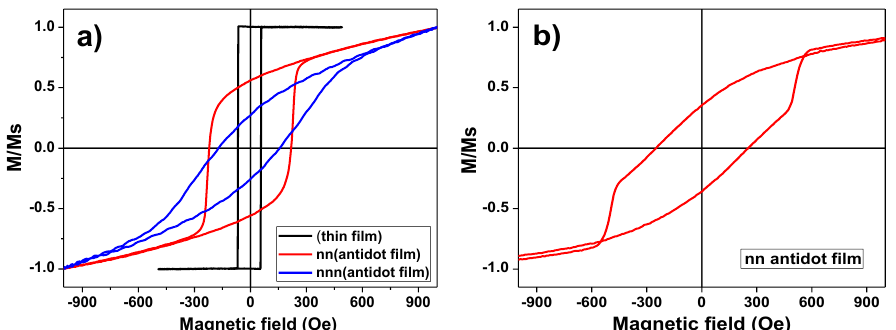
Figure 4. ( a ): Longitudinal Magneto-Optical Kerr Effect (MOKE) hysteresis loops of a 30 nm thick Dy 13 Fe 87 thin film (black line) and antidot film of the same thickness and composition, measured along the nn (red line) and nnn (blue line) directions of the hexagonal lattice. ( b ): Polar MOKE hysteresis loop with an out of plane applied magnetic field for the same antidot thin film.